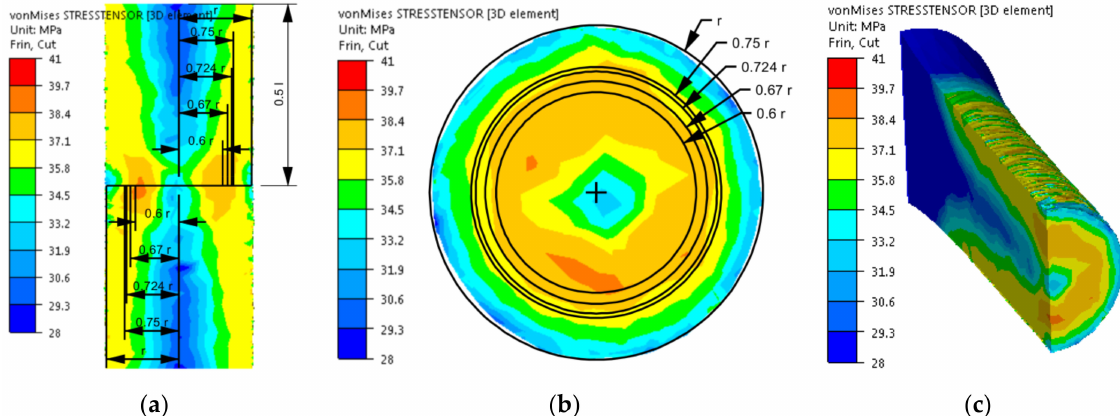
Figure 9. Distribution of the stress intensity of the 5019 aluminium alloy calculated numerically using coefficients from Table 1: ( a ) longitudinal section, ( b ) cross-section—centre of the working part and ( c )